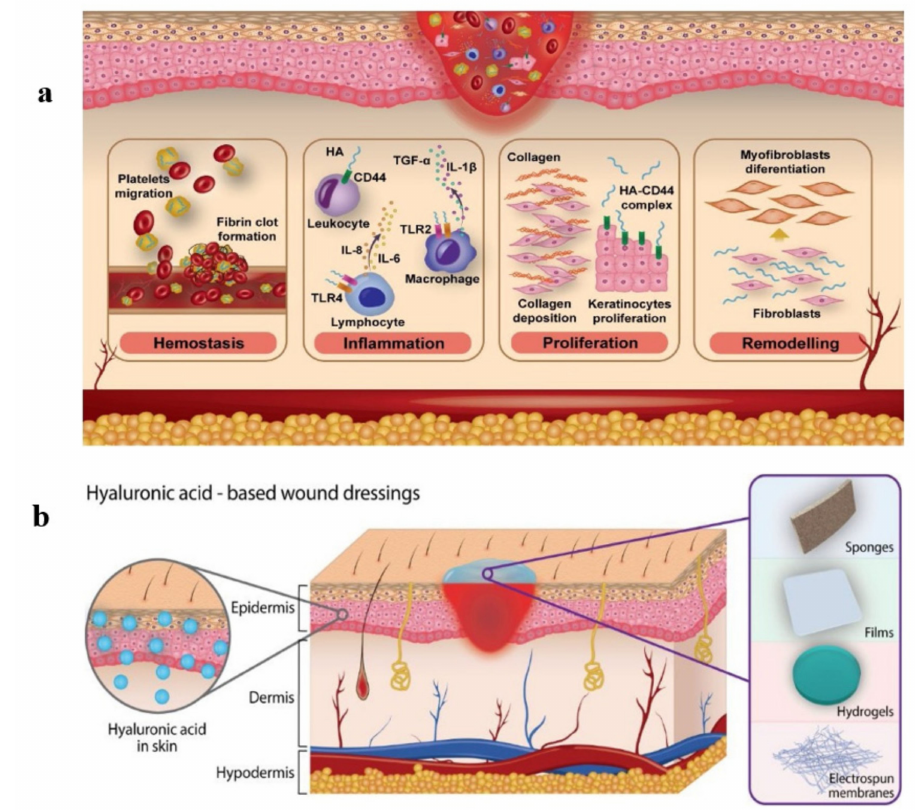
Figure 2. ( a ) Role of HA in phases of skin wound healing; ( b ) various skin wound dressings based on HA, adapted from Graça et al.